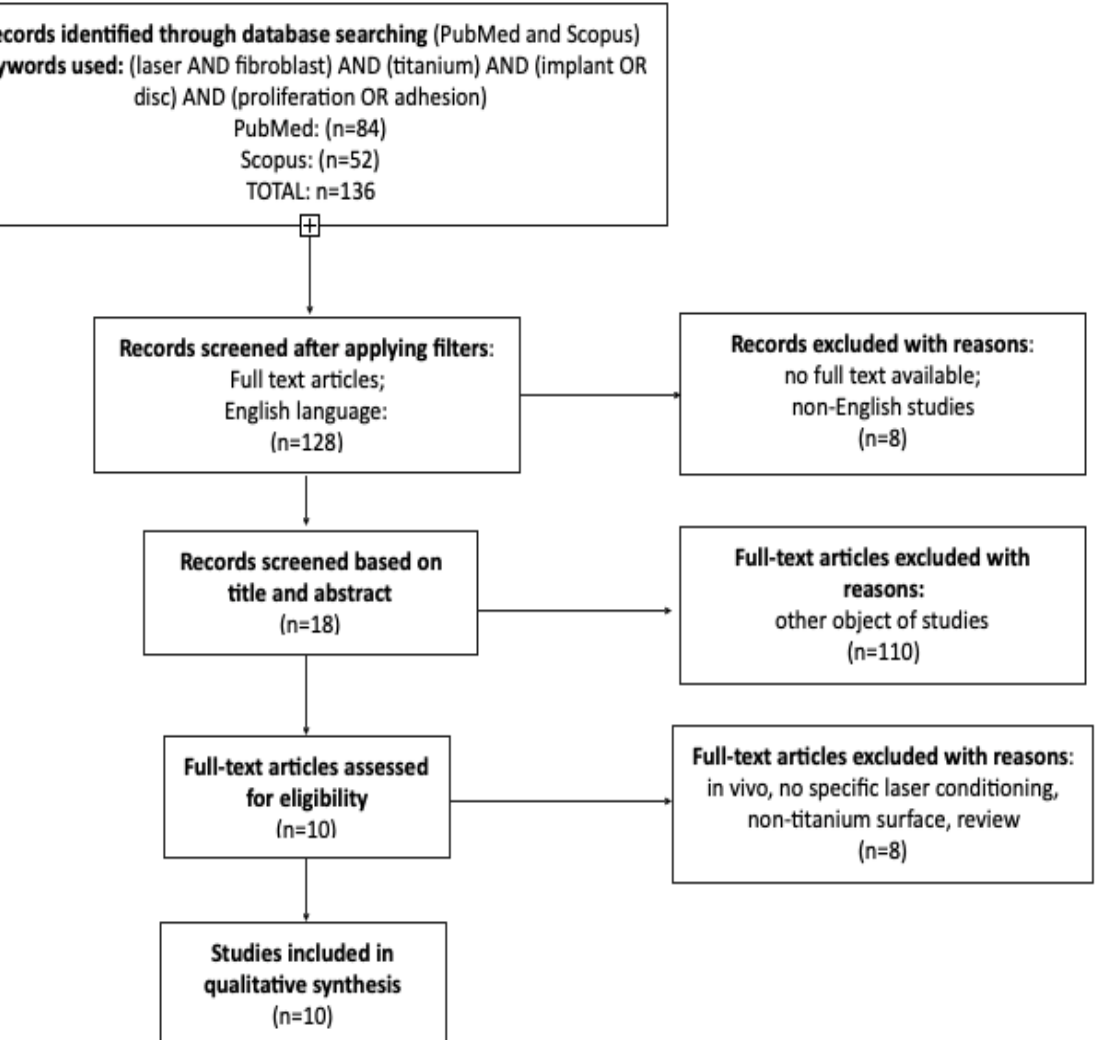
Figure 1. PRISMA flowchart presenting the criteria for the included studies.